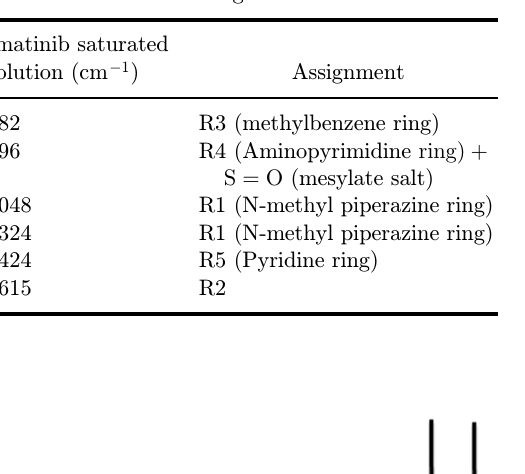
Table 1. Peak assignments for Imatinib.